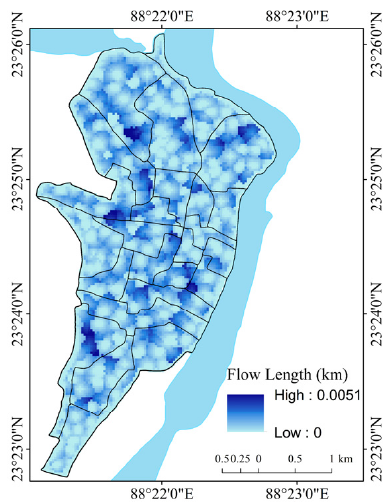
Figure 18. Flow length (2000).